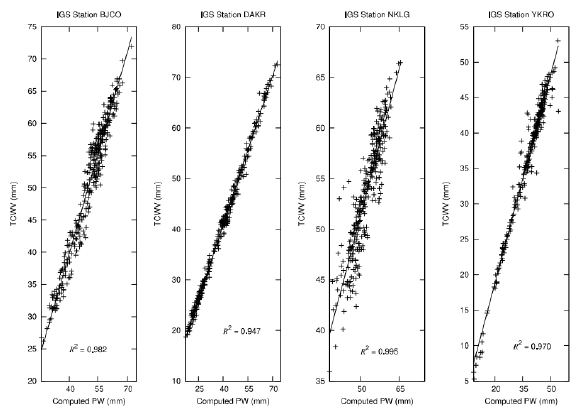
Figure2: CorrelationplotsofcomputedPWforthefourIGSStationsin West Africa against TCWV retrieved from ERA-Interim reanalysis